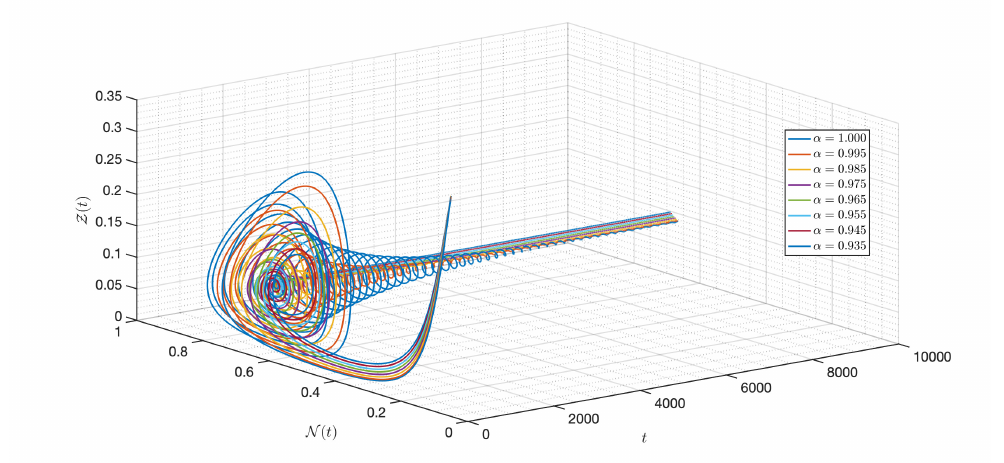
Figure 17. Dynamic of the model (3) for different parameters in Case II